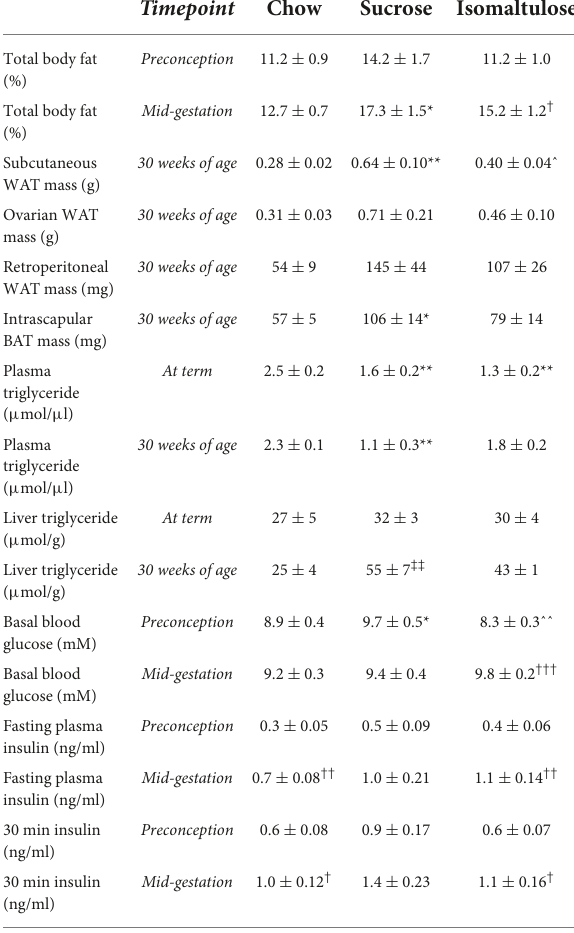
TABLE 2 Dam adiposity, triglyceride levels, and glucose homeostasis before and during pregnancy in Part 1 (sucrose vs. isomaltulose).